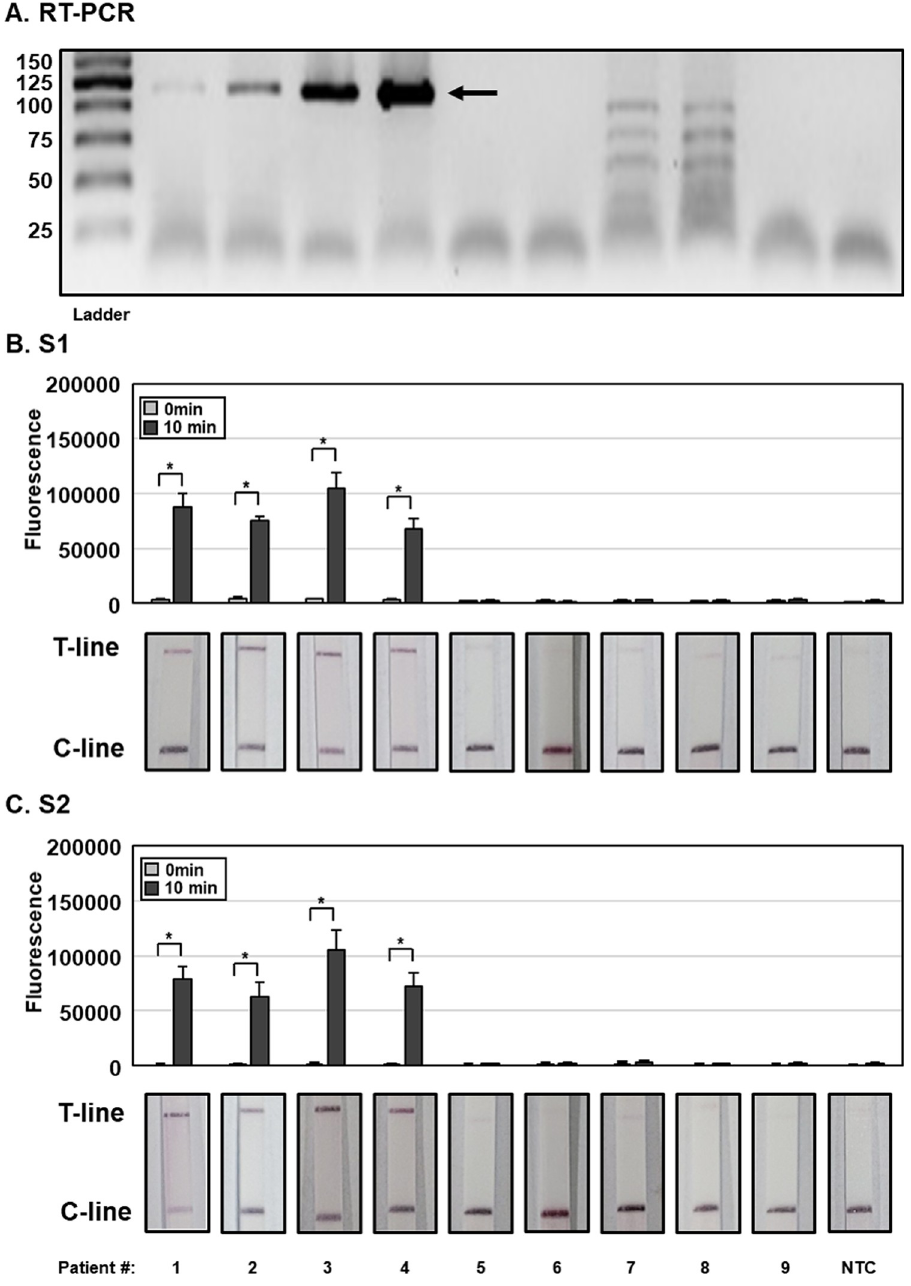
Fig 4. Application of SFTSV DETECTR to clinical samples. (A) RNA was extracted from patient plasma samples and subjected to RT-PCR for SFTSV detection. PCR products (124 bp) were visualized using gel electrophoresis. (B, C) HUDSON-treated patient plasma samples were used to amplify viral nucleic acids using RT-RPA with a primer set specific for the SFTSV S gene. RT-RPA amplicons were detected using SFTSV DETECTR combined with fluorescence assay or lateral flow using gRNAs (A) S1 and (B) S2 corresponding to the S genes of all SFTSV genotypes. Fluorescence saturation occurred within 10 min. Lateral flow assay results were evaluated 2 min after the strip was reacted with the sample. Values are presented as means ± s.d. (error bars) ( n = 3 replicates; � p < 0.05 between samples, two-sample t - test). C-line, control line; T-line, test line; NTC, no template control.